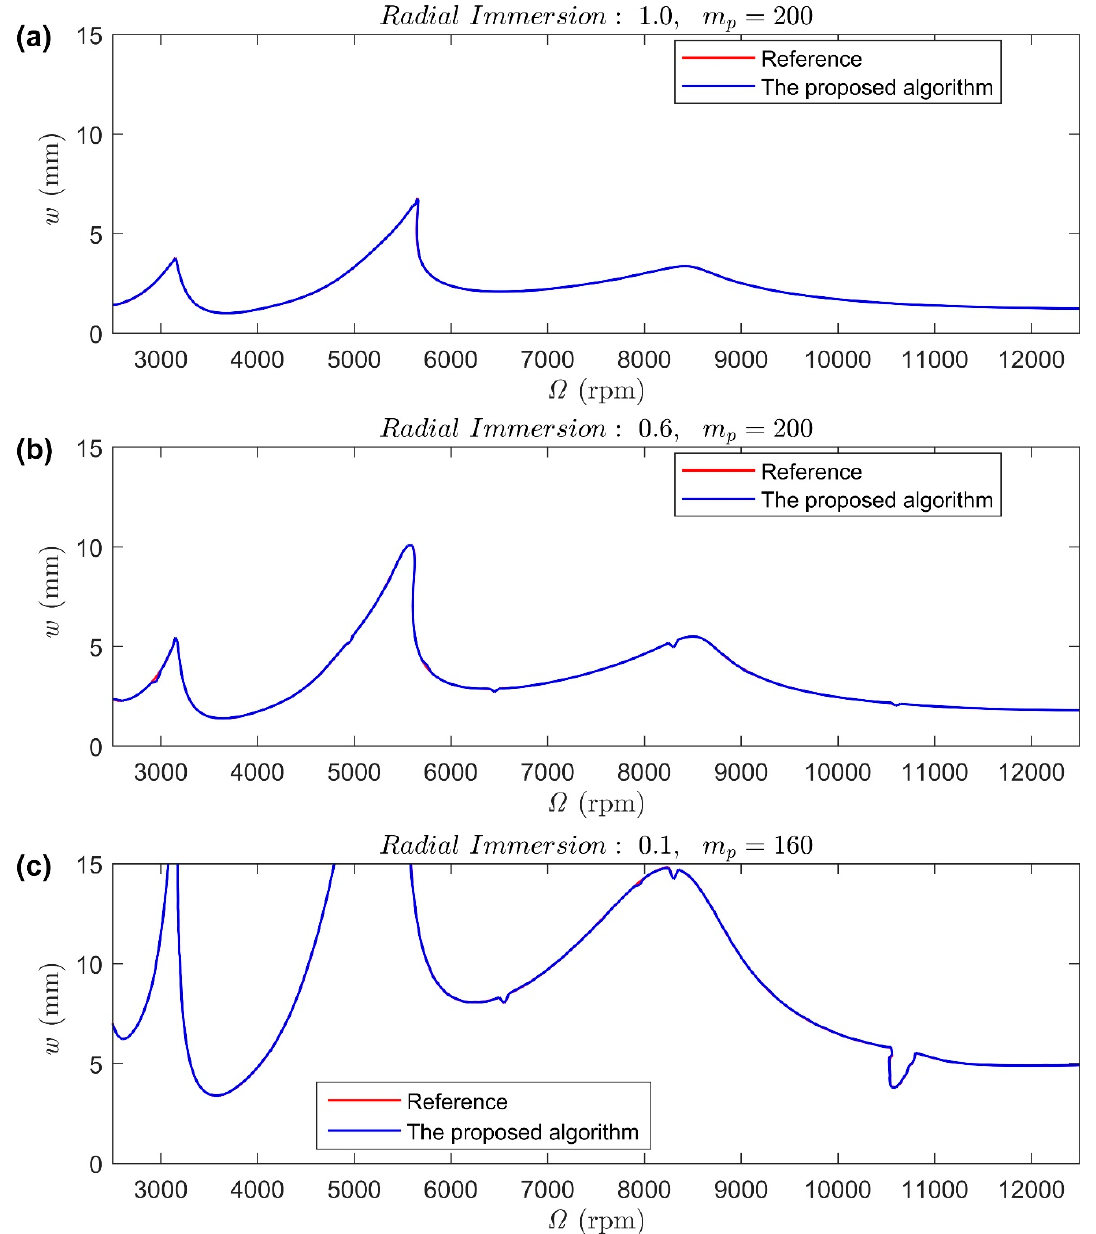
Figure 9. The SLD of the first milling model obtained by the proposed algorithm ( a ) radial immersion 1.0, m p = 200; ( b ) radial immersion 0.6, m p = 200; ( c ) radial immersion 0.1, m p =